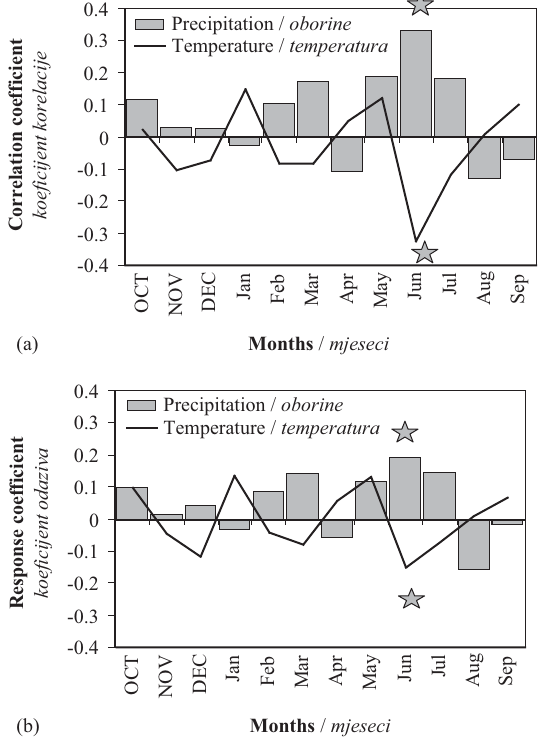
Figure 3 Correlation (a) and response coeffi cients (b) calculated between the residual version of oak chronology of Kobiljak near Zagreb (HR1) and monthly temperature (line) and precipitation (bars) from previous October to current September for the period 1922-2009; stars indicate signifi cance at 95 %